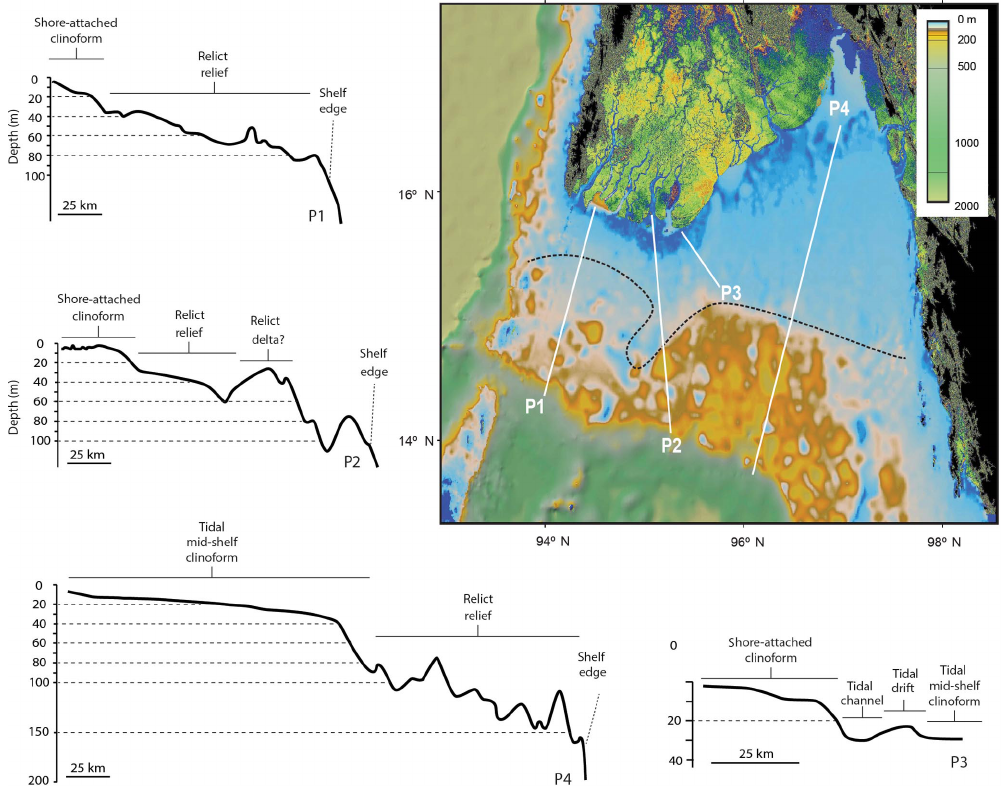
Figure 4. Interpreted bathymetric profiles across the northern Andaman Sea shelf (bathymetric profiles identified on map). Dashed line on map indicates the approximate limit of consistent finely grained sediment deposition on the shelf farthest from shore. The SRTM-derived DEM for the Ayeyawady delta region is shown on